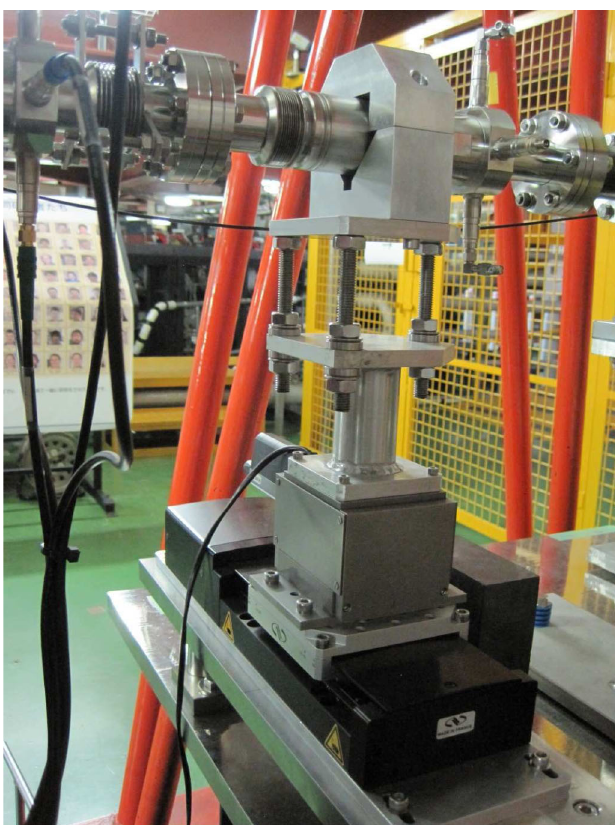
FIG. 6. (a) Stripline output voltage vs time recorded with an oscilloscope (with interpolation). (b) Smoothed Fourier transform of stripline output voltage vs